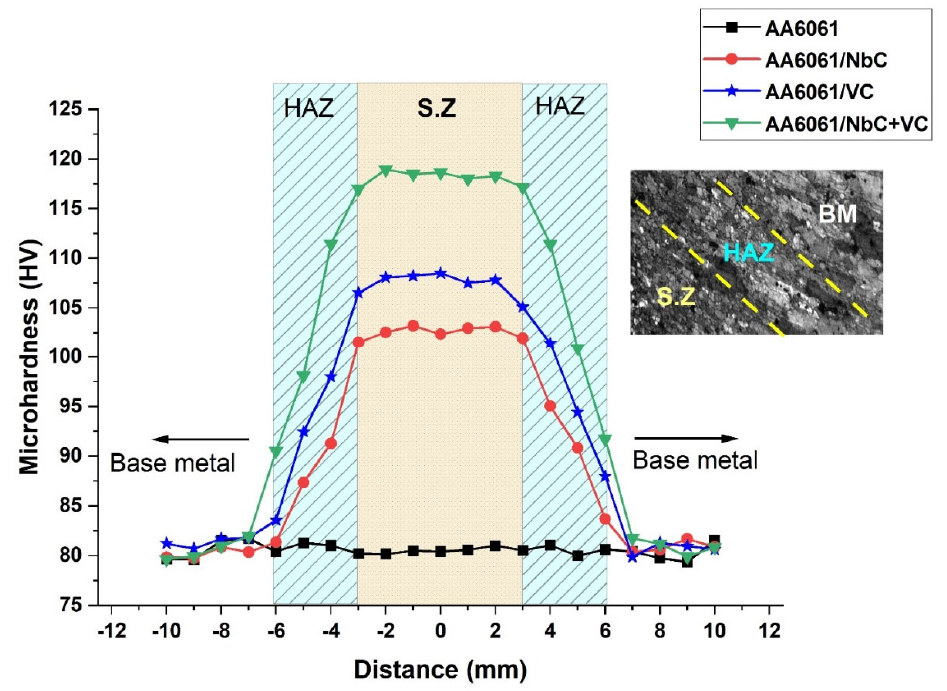
Figure 11. Microhardness, profile in the FSP, stirred zone, and heat ‐ affected